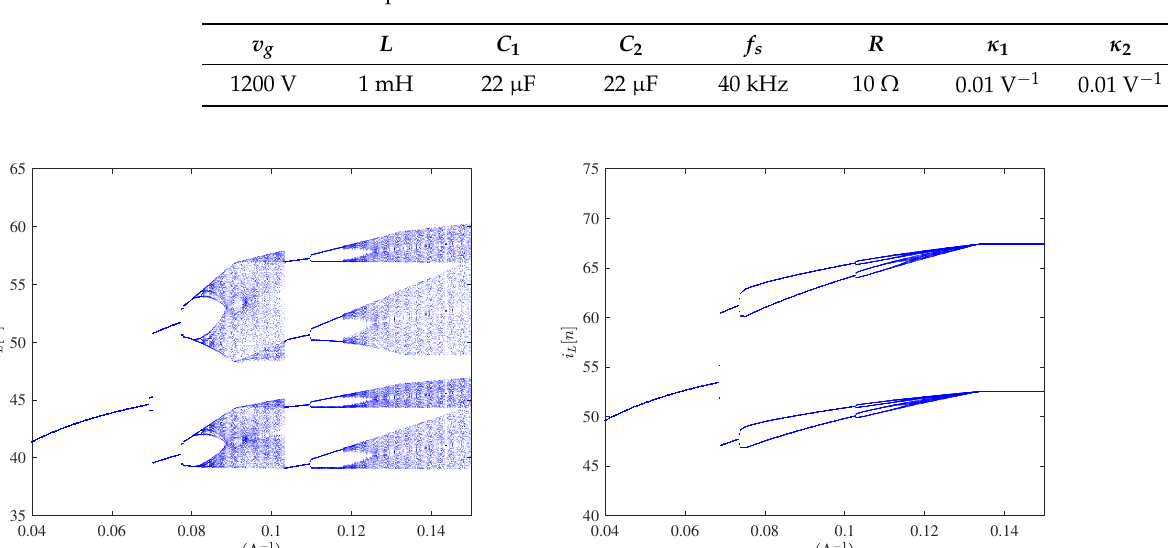
Table 2. The fixed parameter values used in numerical simulations.